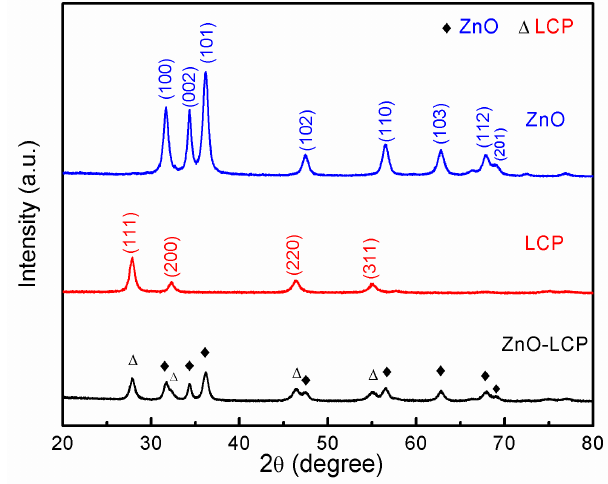
Figure 1. XRD patterns of the prepared ZnO, LCP and ZnO-LCP composite. Table 1. The lattice parameters of ZnO and LCP.